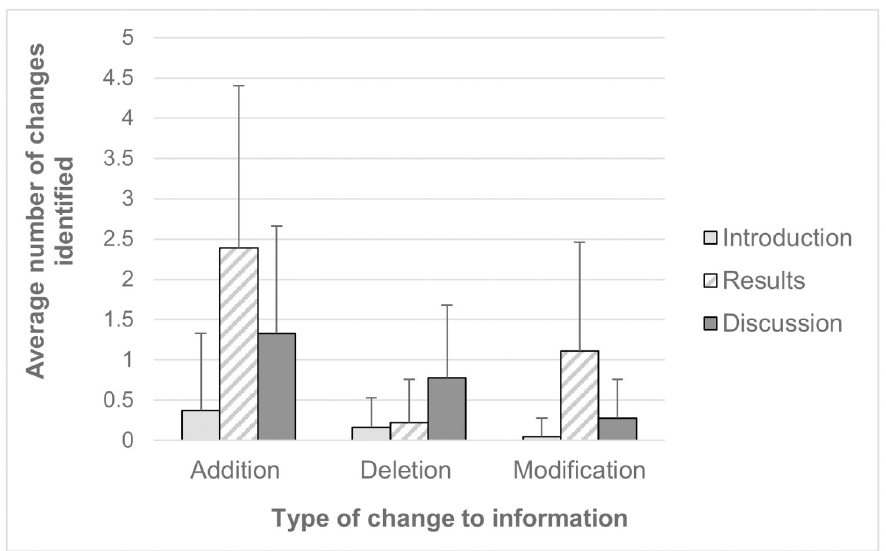
Fig 1. Average number of changes between the preprint and final versions. The number of changes as identified by students in the introduction (light gray bars), results (hatched bars), and discussion (dark gray bars) sections. Error bars represent the standard deviations for each